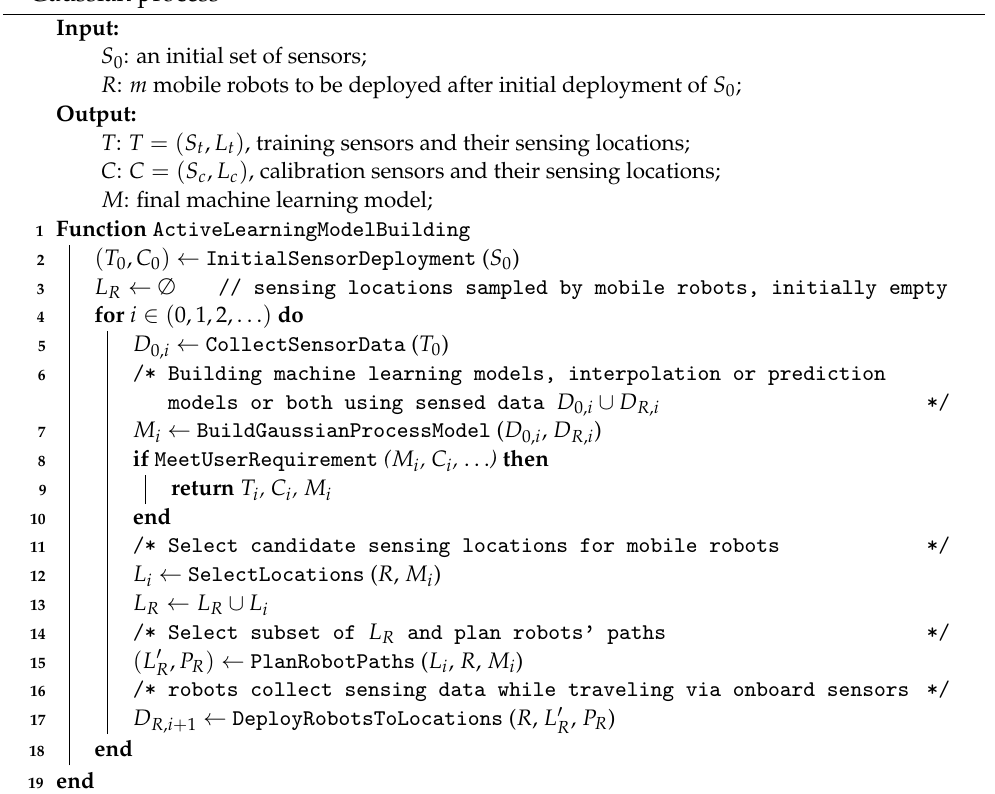
Algorithm 2: Model-based heterogeneous sensing with active learning and Gaussian